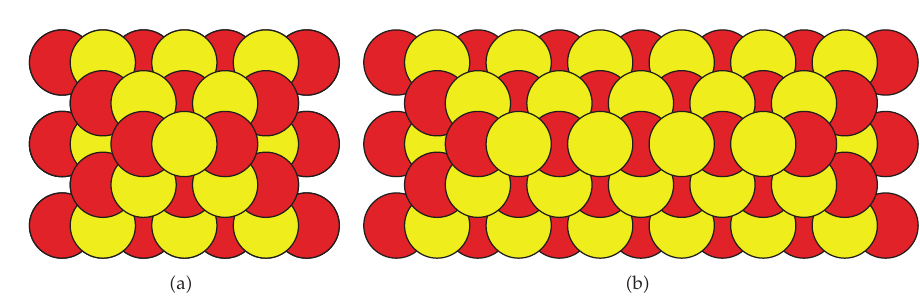
Figure 2: Infinite pyramids with one and four balls in the top row, with generating functions given, and Z pyramid respectively, by Z pyramid 0 3